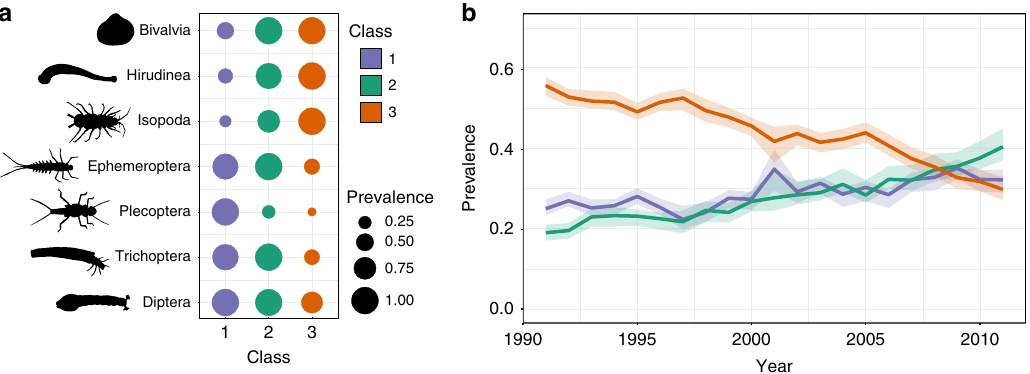
Fig. 1 Macroinvertebrate community composition and change across England and Wales 1991 – 2011. a Characteristic changes in the community among the three biological classes: the mean prevalence of families within the seven higher taxa showing the greatest change among classes, scaled so that the relative prevalence of each taxon = 1 in the class where it was most prevalent, and b the change in prevalence of the three classes, with bootstrapped 95% con fi dence limits. See Supplementary Fig. 4a for a full version of a . Source data are provided as a Source Data fi le. Invertebrate silhouettes drawn by